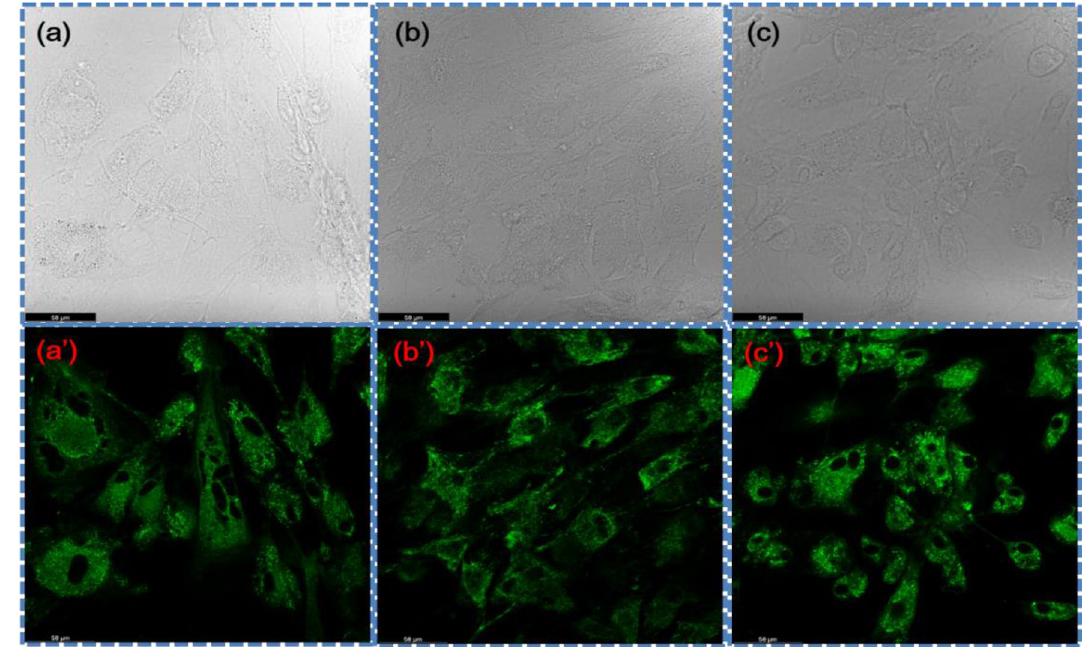
Figure 8. Confocal microscopic images of rabbit chondrocyte proliferation study staining ( a,a ʹ ) with mitotracker assay kit with scaffold, ( b,b ʹ ) with mitotracker assay kit immersed in SGNR, and ( c,c ʹ ) with mitotracker assay kit immersed in SGNR and treated with NIR